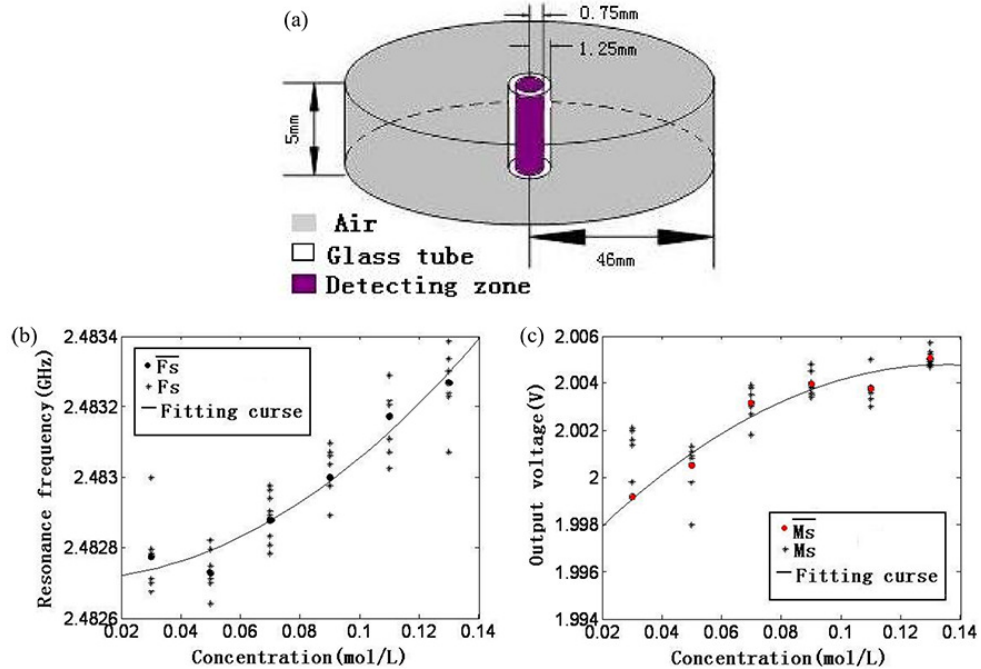
Figure 5. Glucose concentration detection using a TM 010 mode cylindrical cavity. ( a ) Configuration of the sensor. ( b ) Frequency shift depending on the glucose concentration. ( c ) Variation in the output voltage depending on the glucose concentration (Reprinted with permission from [63]; © 2021